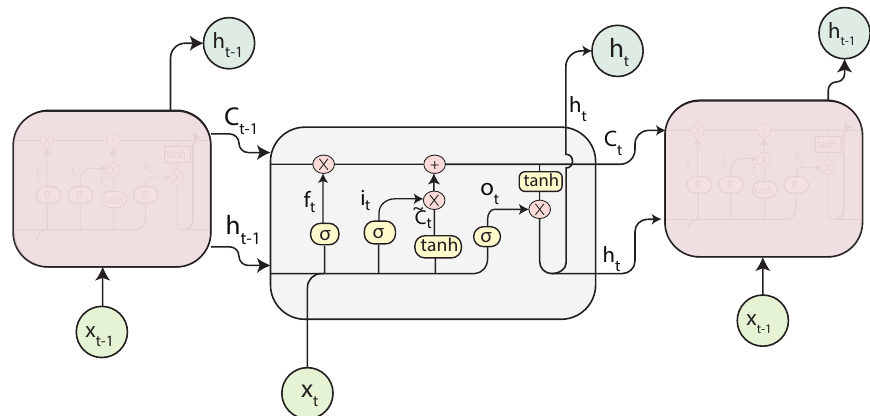
Figure 5. Structure of an LSTM